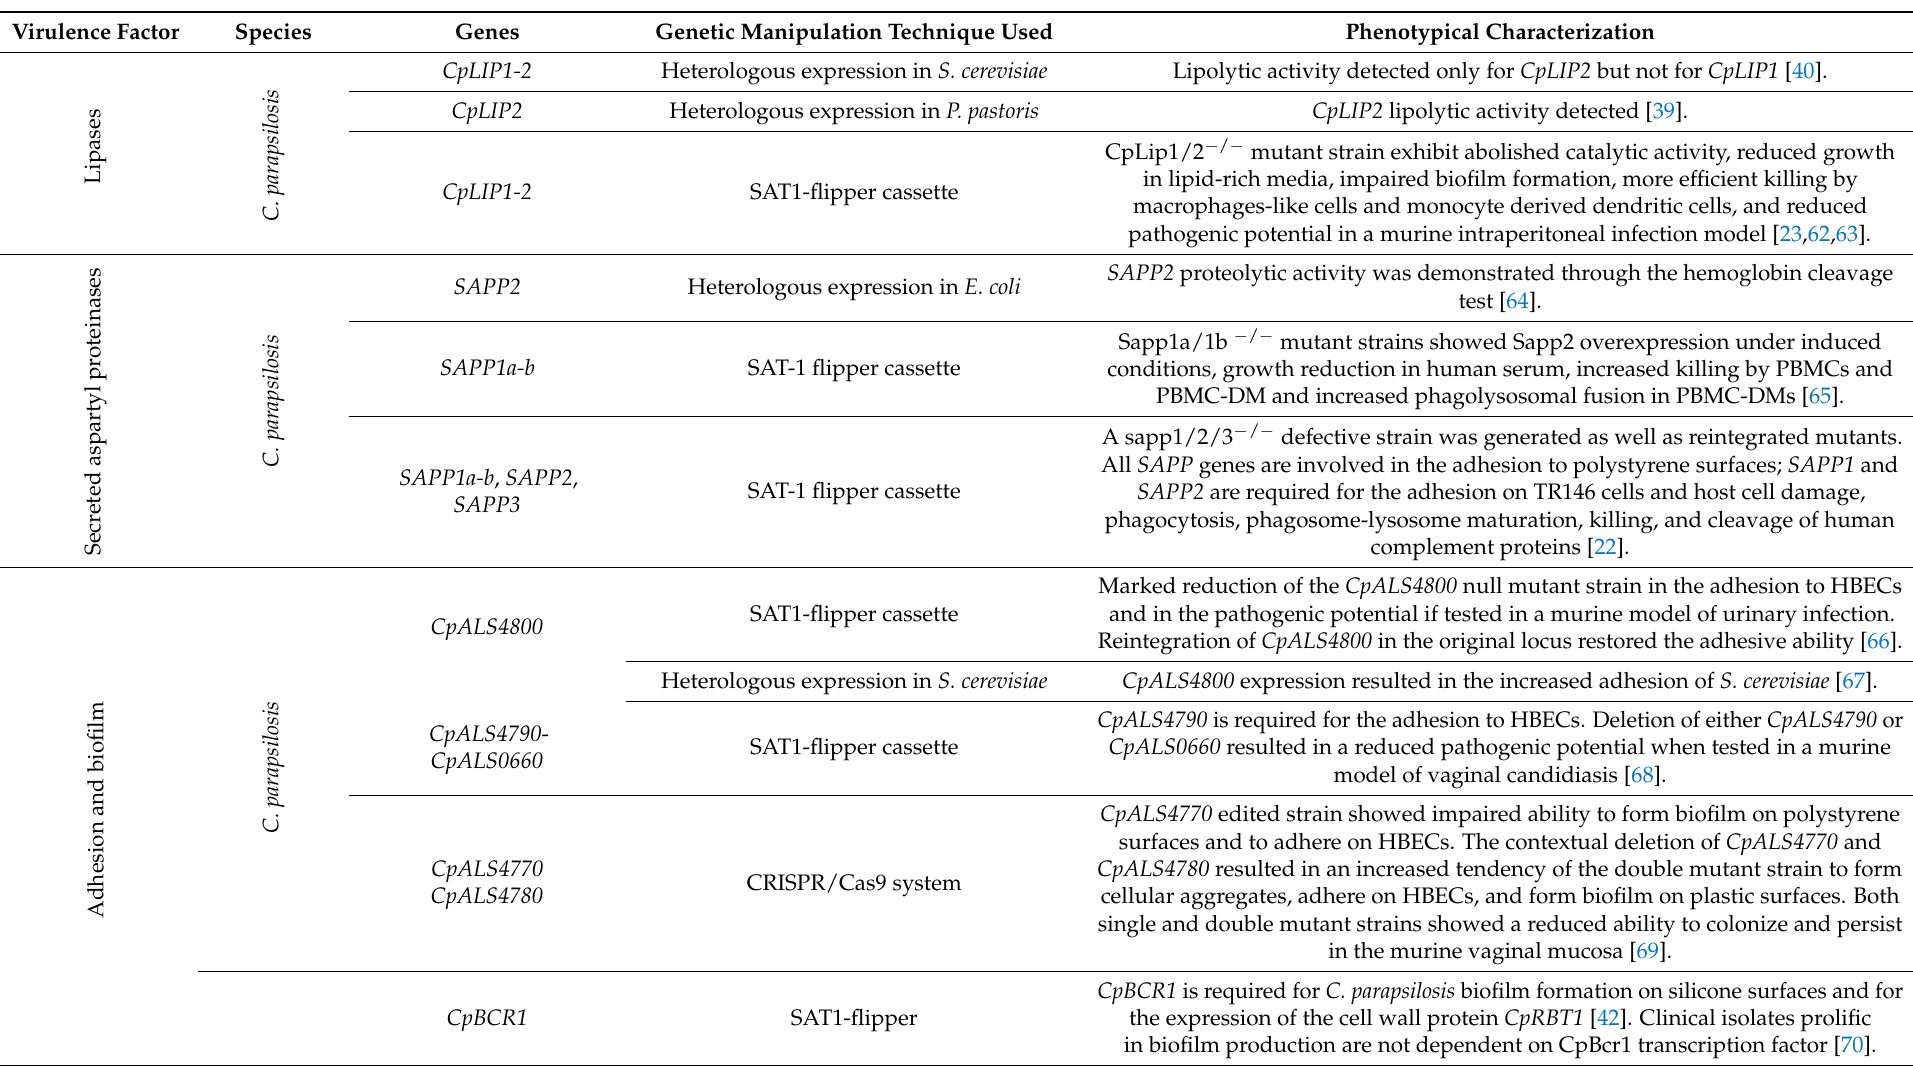
Table 1. Overview of the genetic manipulation studies dissecting C. parapsilosis species complex virulence factor and summarized outcome of the phenotypical